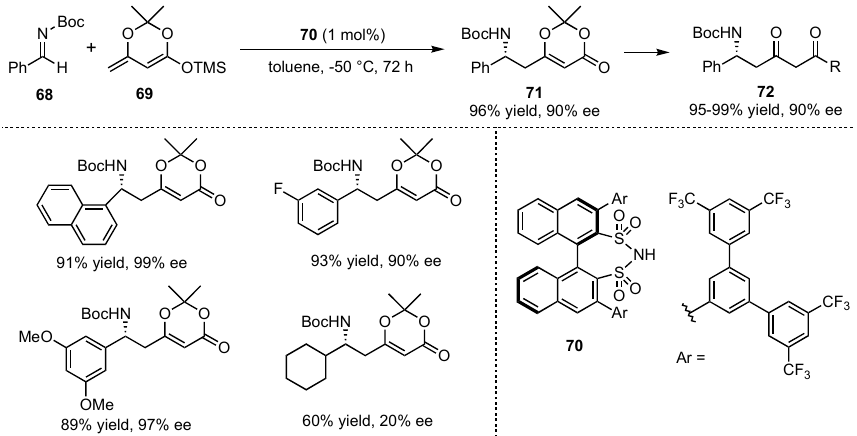
Scheme 18. Chiral disulfonimide organocatalyzed VMMnRs and subsequent transformation to useful enantiomerically pure building blocks presented by List et al.